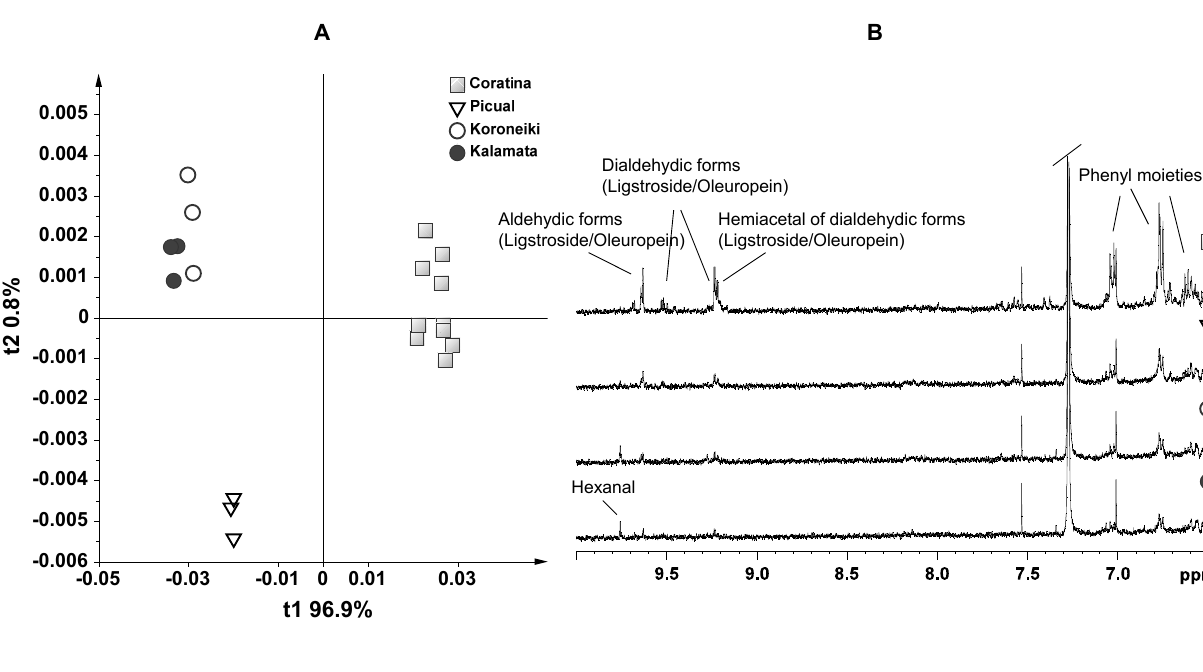
Figure 1. ( A ) PCA (t1/t2) score plot for monovarietal Coratina, Picual, Kalamata and Koroneiki samples (two components give R 2 = 0.98 and Q 2 = 0.943); ( B ) expansions of the 1 H NMR spectra of monovarietal Coratina, Picual, Kalamata and Koroneiki samples used for the